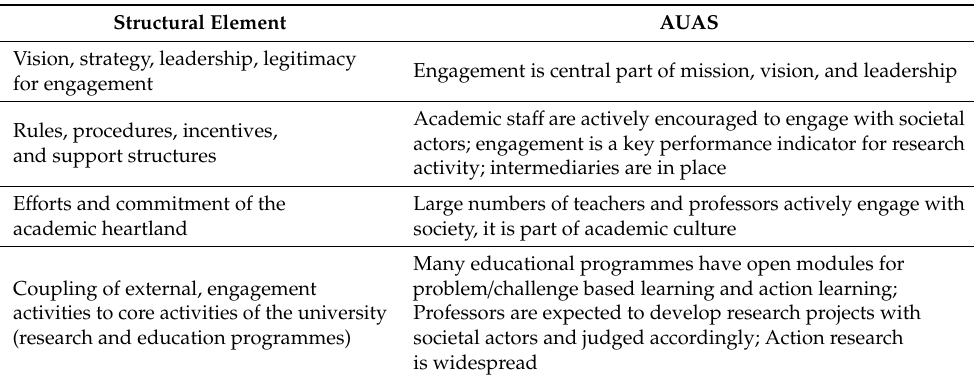
Table 2. Structural elements favouring engagement activity (as identified by S á nchez-Barrioluengo and Benneworth 2019). AUAS, Amsterdam University of Applied